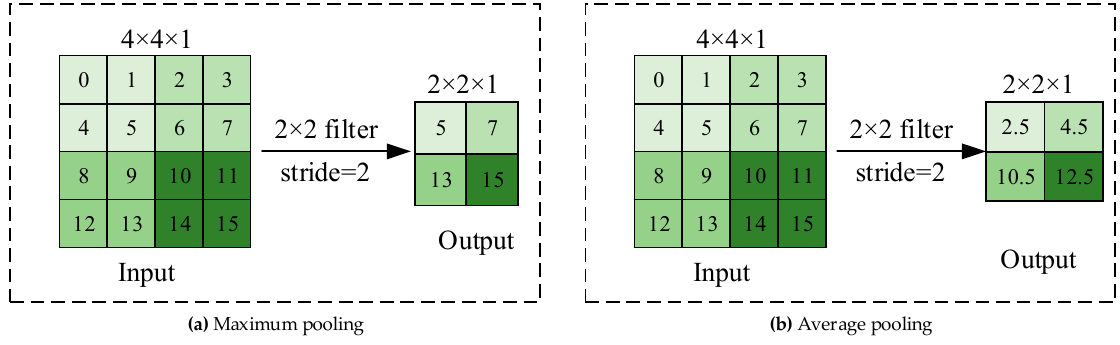
Figure 3. The process of pooling operation. For classification tasks, various CNN-based classification models have been devel- oped in DL-related research, including AlexNet, VGGNet, GoogLeNet, ResNet, Mo- bileNet, and EfficientNet. AlexNet [45] was proposed in 2012 and was the champion net- work in the ILSVRC-2012 competition. This network contains five convolutional layers and three fully connected layers. AlexNet has the following four highlights: (a) it is the first model to use a GPU device for network acceleration training; (b) rectified linear units (ReLUs) were used as the activation function; (c) local response normalization was used; (d) in the first two layers of the fully connected layer, the dropout operation was used to reduce overfitting. Then, the deeper networks appeared, such as VGG16, VGG19, Goog- LeNet. These networks use smaller stacked kernels but have lower memory during infer- ence [46]. Later, researchers found that when the number of layers of a deep CNN reached a certain depth, blindly increasing the number of layers would not improve the classifica- tion performance but would cause the network to converge more slowly [47,48]. Until 2015, Microsoft lab proposed the ResNet network and won the first place in the classifica- tion task of the ImageNet competition. The network creatively proposed residual blocks and shortcut connections [49], which solves the problem of gradient elimination or gradi- ent explosion, making it possible to build a deeper network model. ResNet influenced the development direction of DL in academia and industry in 2016. MobileNet was proposed by the Google teams in 2017 and was designed for mobile and embedded vision applica- tions [50]. In 2019, the Google teams proposed another outstanding network: EfficientNet